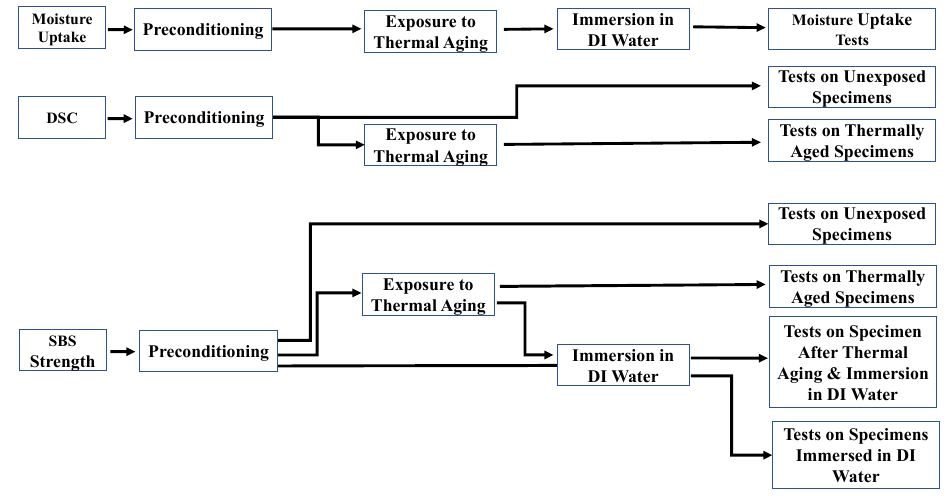
Figure 1. Schematic of exposure conditions.